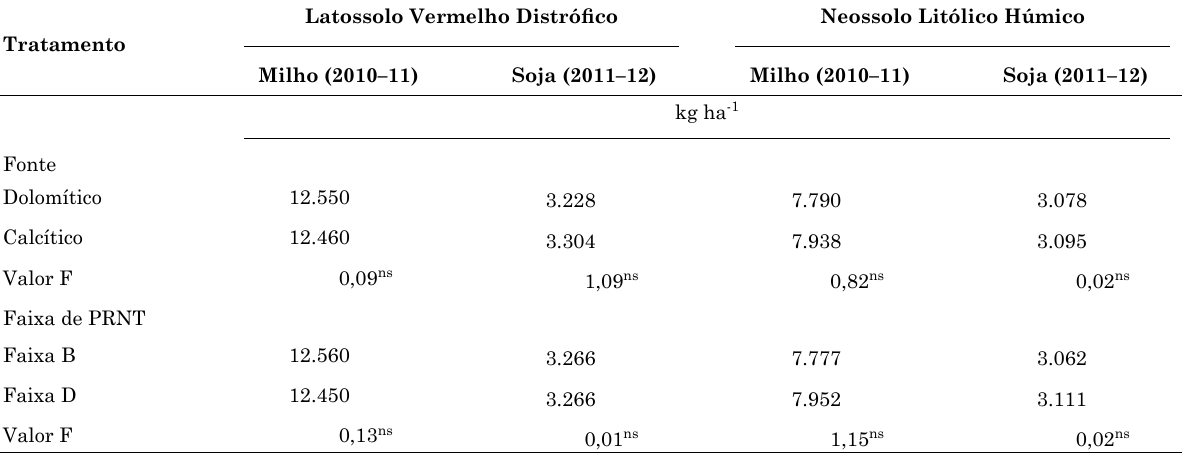
Quadro 5. Produtividade de grãos de milho (2010/11) e soja (2011/12), no Latossolo Vermelho Distrófico, e de soja (2010/11) e milho (2011/12), no Neossolo Litólico Húmico, de acordo com as fontes de calcário dolomítico e calcítico e as faixas B e d de poder relativo de neutralização total (prnt) dos corretivos aplicados na superfície do solo em sistema plantio direto. os valores são médias de quatro doses de